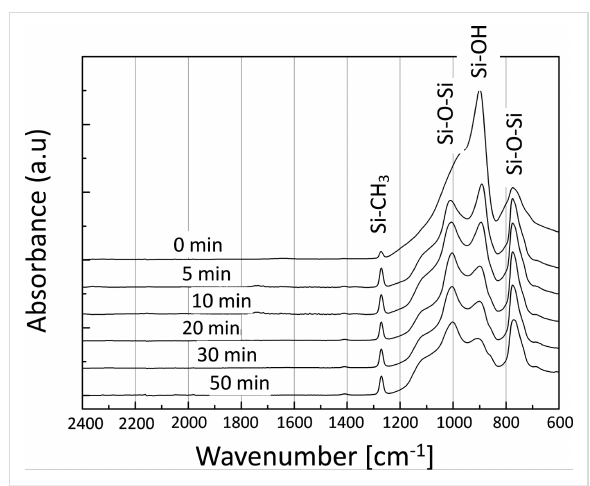
Figure 2: Evolution of the FTIR absorption spectra of the ICSG resists during condensation at 110 °C for different times.